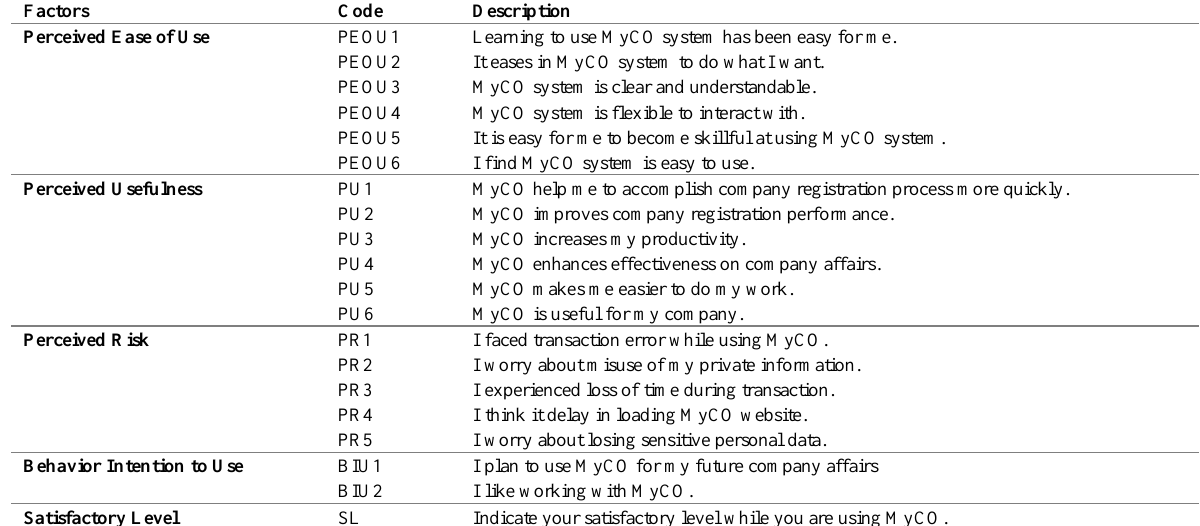
Table 1: factors utilized to explore user’s perceptions